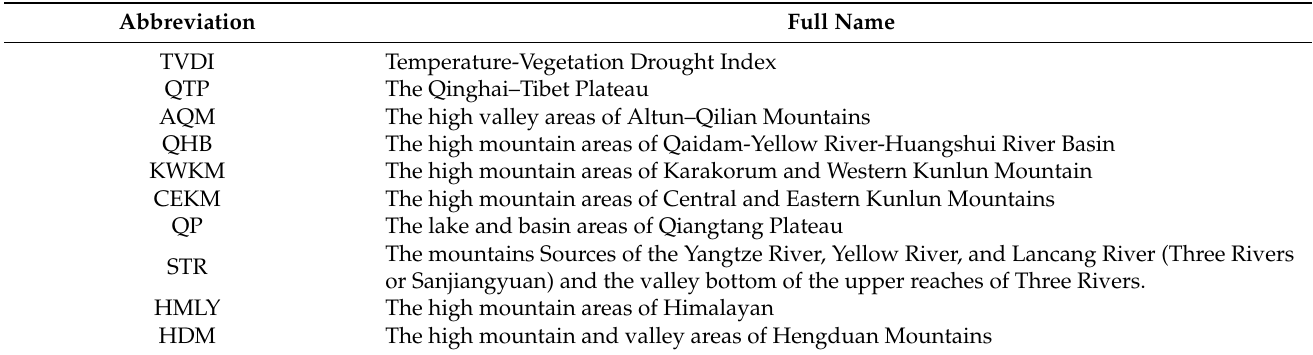
Table A1. Full name of abbreviation in the text.